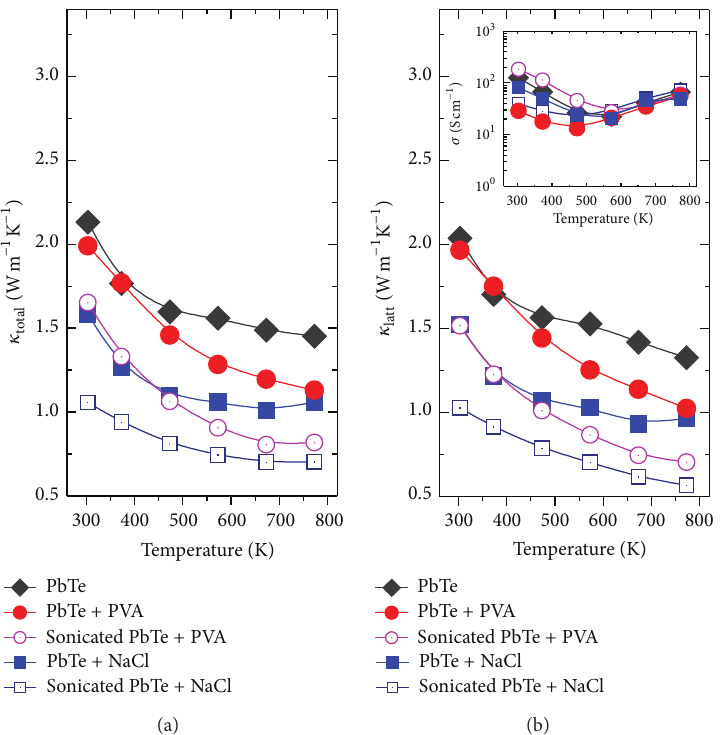
Figure 3: (a) Total and (b) lattice thermal conductivities as a function of temperature for PbTe and PVA- and NaCl-embedded PbTe samples before and after sonication, respectively. The inset shows the temperature dependence of electrical conductivity for all samples.